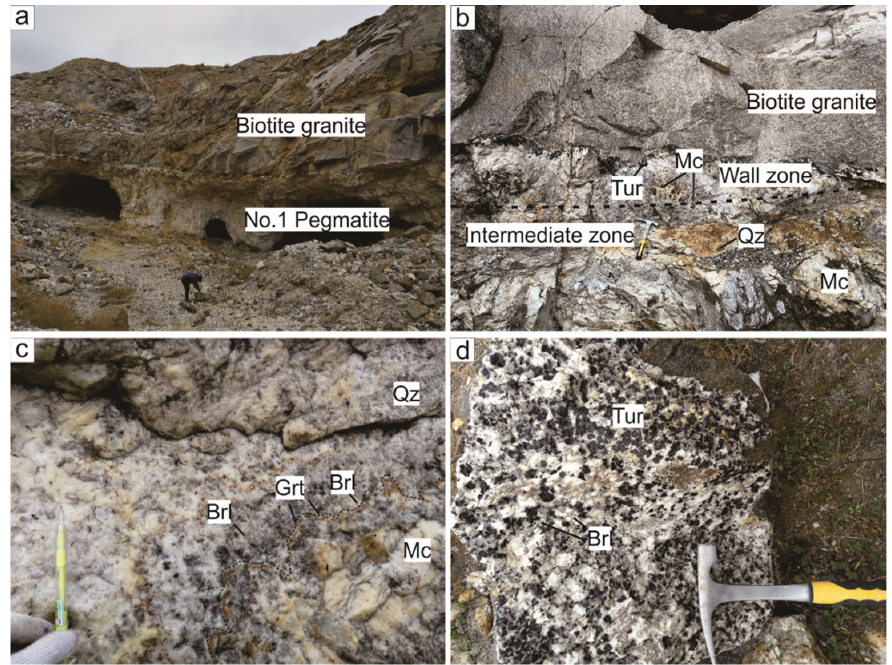
Figure 3. Field photographs of ( a ) The Dakalasu No.1 pegmatitic dike emplaced into the Dakalasu biotite granite; ( b ) The wall zone is dominated by coarse-grained quartz, microcline, tourmaline, beryl, and fine- to medium-grained garnet, and the intermediated zone bears blocky microline and quartz; ( c ) Garnet and beryl occur in contact with the intermediate zone along the wall zone; ( d ) Beryl coexisting with abundant tourmaline (black), microcline (white) and quartz (gray). Abbrevia- tions: Brl = beryl, Grt = garnet, Mc = microcline, Ms = muscovite, Qz = quartz and Tur = tourmaline. Hammer = 30cm, pen = 13.5cm.